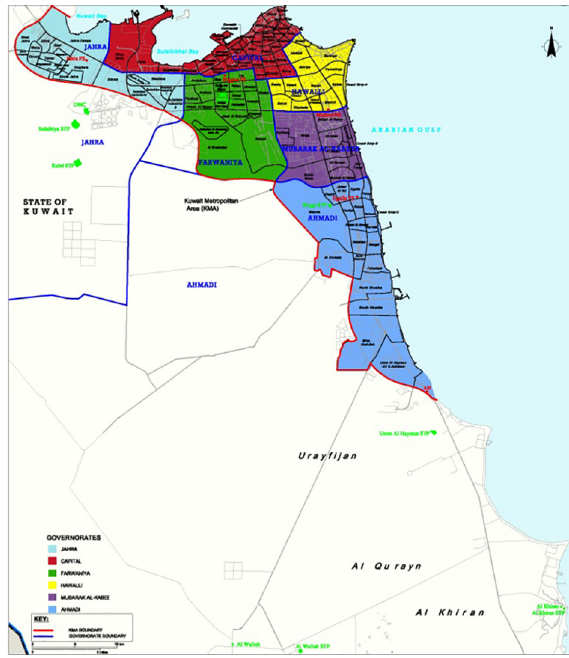
Figure 1. Map of Kuwait City (Ardiay catchment includes areas in green, red and